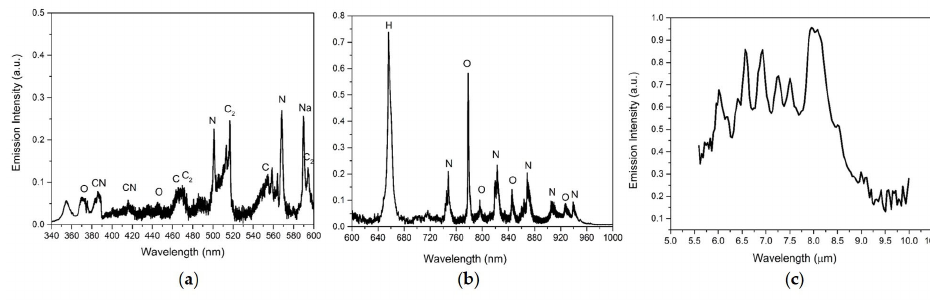
Figure 2. UV/Vis/NIR ( a , b ) + LWIR ( c ) LIBS spectrum of solid acetaminophen tablets.